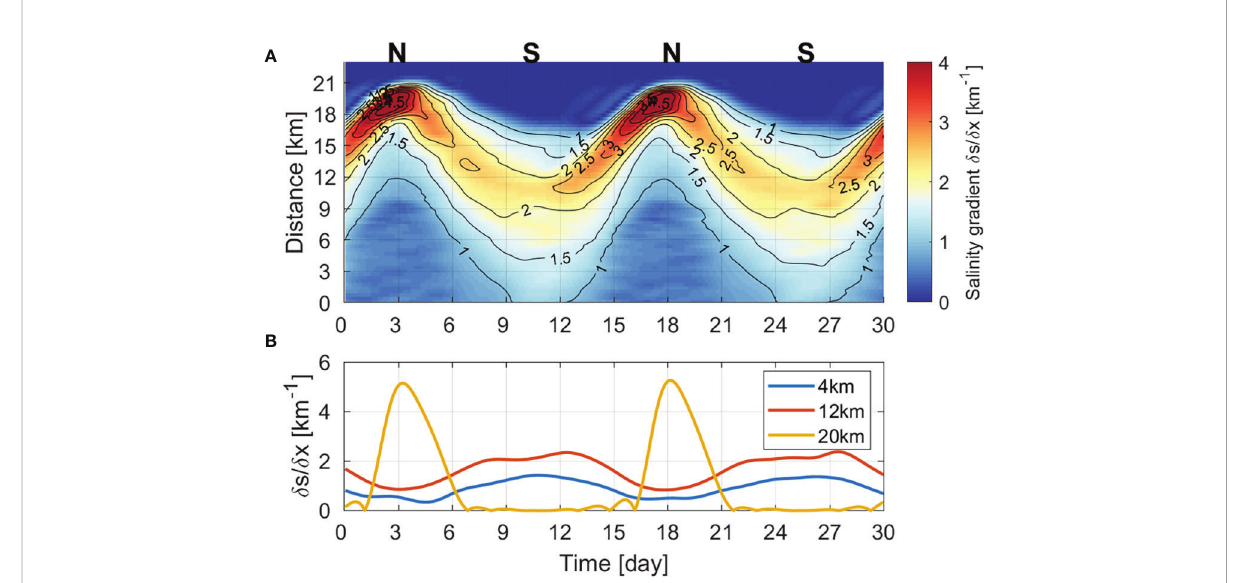
FIGURE 7 Hovmöller diagram of (A) horizontal salinity gradient along the channel (unit: km -1 ) and (B) time series of salinity gradient at 4, 12, and 20 km.